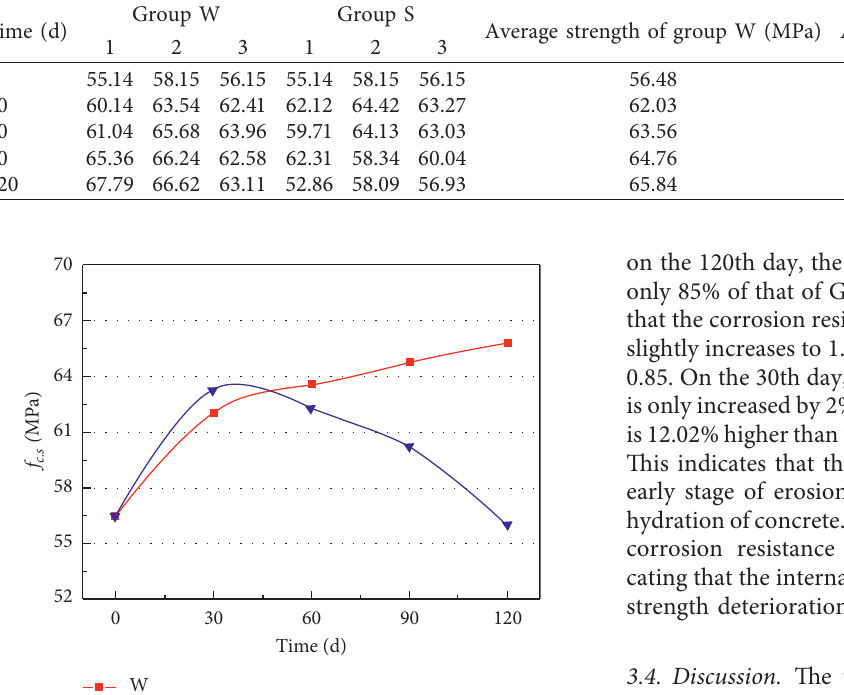
Table 7: Uniaxial compressive strength and corrosion resistance coefficient of concrete specimens.